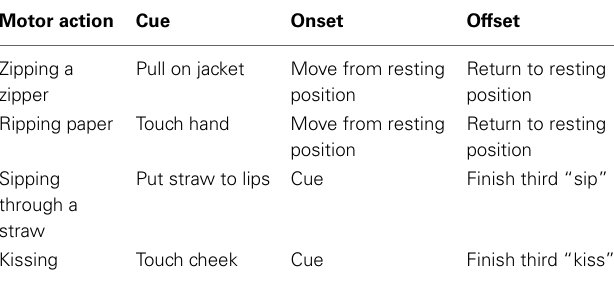
Table 2 | Four Actions Performed During the Motor Task